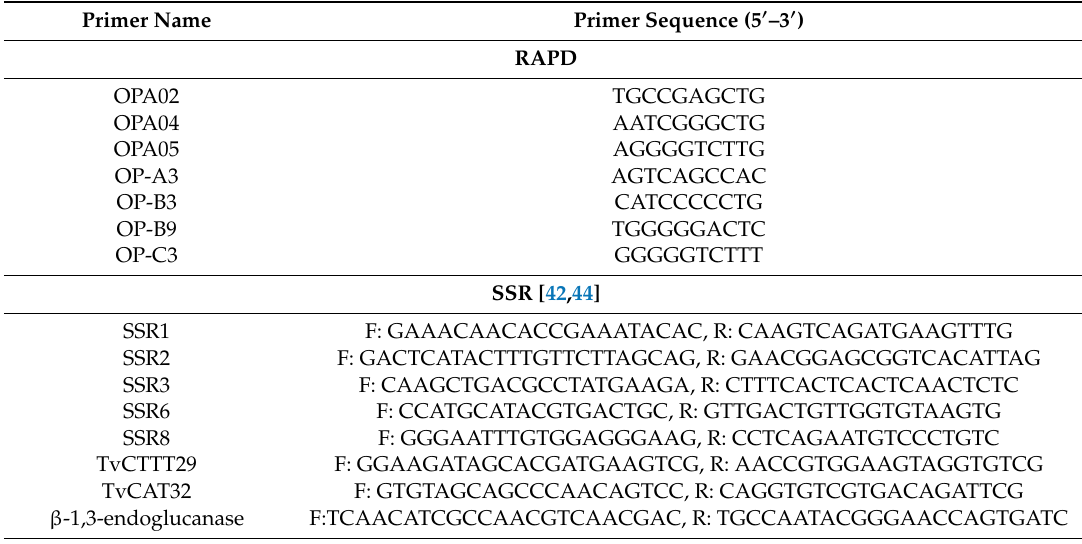
Table 1. Design of species-specific β -1,3-endoglucanase, microsatellite loci and random primers used in this study for the identification of Trichoderma spp. and its genetic